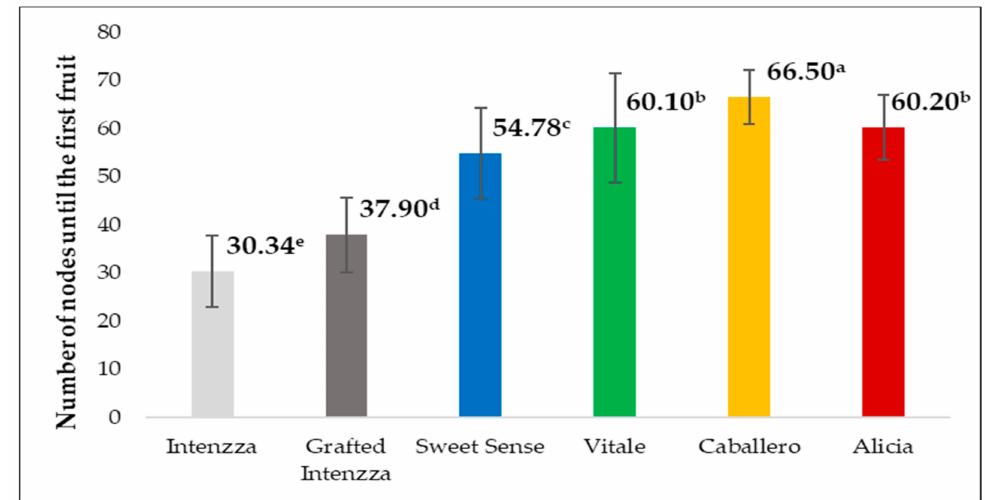
Figure 8. Number of nodes until the first fruit for the five cultivars of papaya planted under greenhouse. Di ff erent letters mean significant di ff erences, at p -value < 0.05.